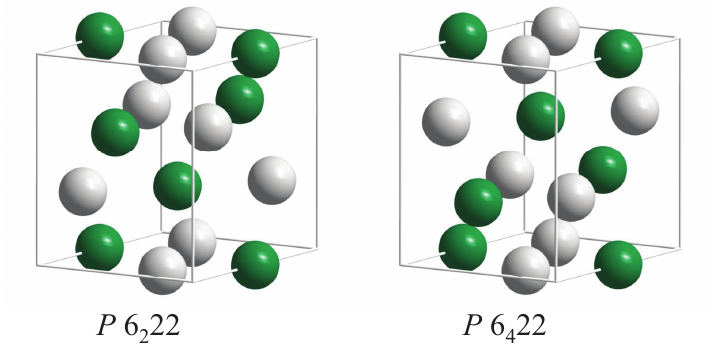
Figure 10. The CrSi 2 structure of quartz (SiO 2 ) and transition metal C 40 compounds. The enantiomor- phous pair of structures in the chiral space groups P 6 2 22 (180) and P 6 4 22 (181) are shown. Transition metal atoms (Cr) are green (dark), and the main group elements (Si) are shown in grey (light). (For quartz, green atoms correspond to Si and grey ones to